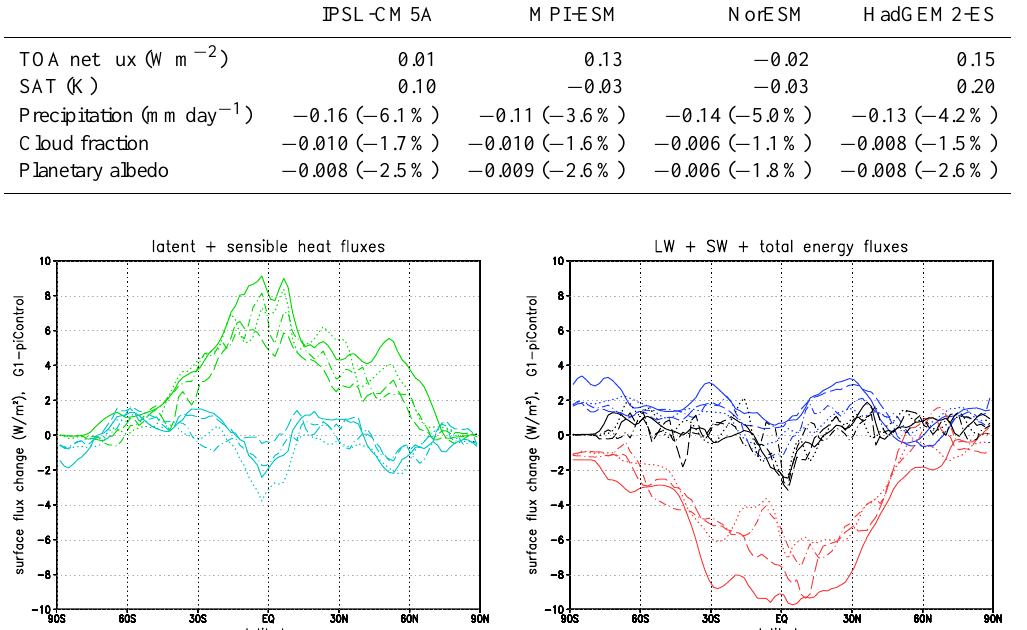
Fig. 2. Differences in zonally-averaged surface net downward energy fluxes between the simulations G1 and piControl in Wm − 2 from the four ESMs. Solid: IPSL-CM5A, dashed: MPI-ESM, dotted: NorESM, dot-dashed: HadGEM2-ES. Left panel: latent (green) and sensible (cyan) heat fluxes; right panel: longwave radiation (blue), shortwave radiation (red) and sum of all four components (black). All fluxes are defined as positive in the downward